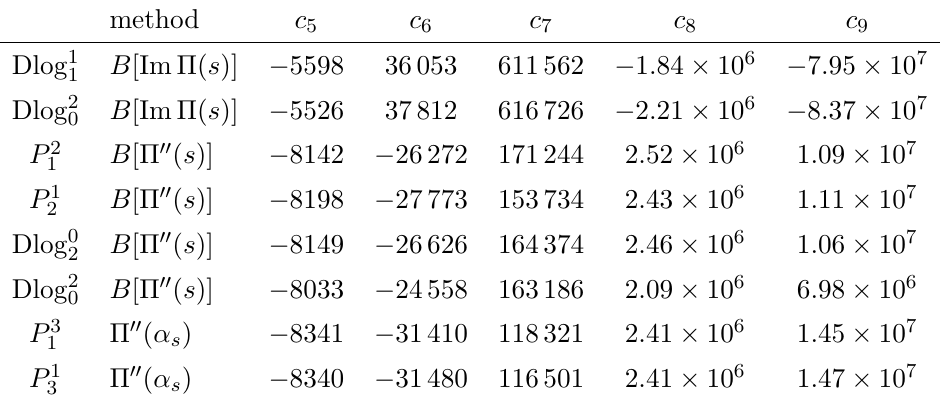
Table 2. Perturbative coefficients of Im Π( s ) , c n , for N f = 5 predicted by PAs and D-log PAs in QCD. In “method” we indicate if the results were obtained from the Borel transforms or from the α s